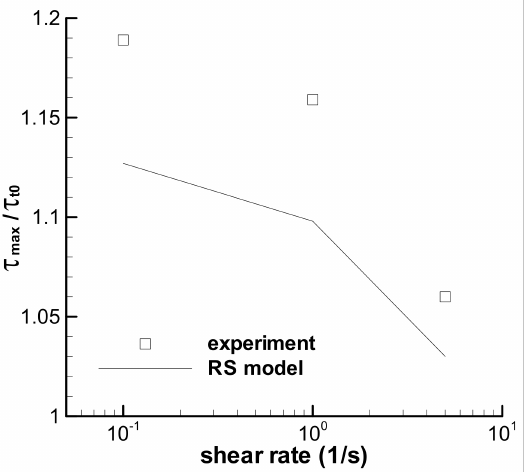
Figure 6. Ratios of the maximum shear stress over the stress at t 0 = 1 s for three triangular loops with t 0 = 1 s. Symbol is the experimental data [35], and line is the